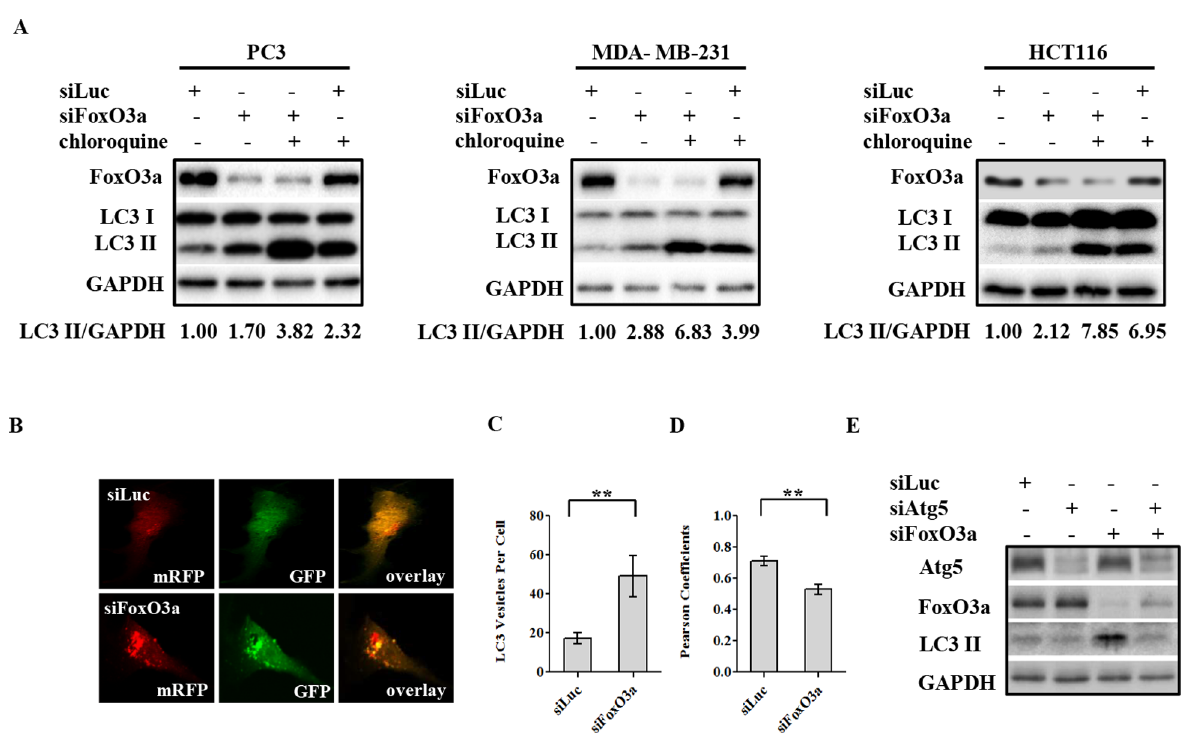
Fig. 2. FoxO3a knockdown increases autophagic flux. (A) PC3, MDA-MB-231, and HCT116 cells were transfected with control siRNA (siLuc) or that targeting FoxO3a (siFoxO3a). Subsequently, these cells were exposed to control vehicle or 50 m M chloroquine 72 h post transfection for 3 h before cell lysates preparation for immunoblot analysis of the indicated proteins. (B) Confocal microscopy of MDA-MB231 cell stably expressing tandem fluorescent mRFP-GFP-LC3 following transfection by either control or FoxO3a siRNA. Images were taken 72 h after transfection of the indicated siRNA. (C) Quantitative analysis of the images from the experiment shown in panel B using MetaMorph software to determine the average number of RFP-positive particles per cell in control (siLuc) and siFoxO3a treated cells. (D) Colocalization analysis of RFP and GFP from experiment described in panel B to assess autophagic progression. RFP and GFP colocalization indicated by Pearson Coefficients was analyzed by ImageJ software. In both (C) and (D), . 50 cells were analyzed for each condition. Data are presented as Mean ¡ S.E.M. (‘‘**’’, p , 0.01), and detailed methods are described in Experimental Procedures. (E) PC3 cells were transfected with control siRNA (siLuc) or that targeting Atg5 (siAtg5), FoxO3a (siFoxO3a), or combination of both, as indicated. Cells were harvested 72 h after transfection and the lysates were processed for